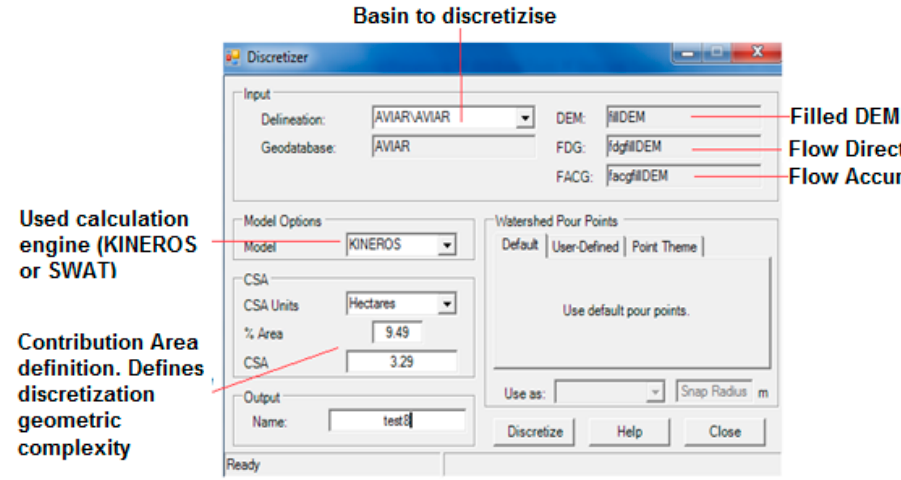
Figure 5. Aviar Basin discretization scheme using KINEROS 2.